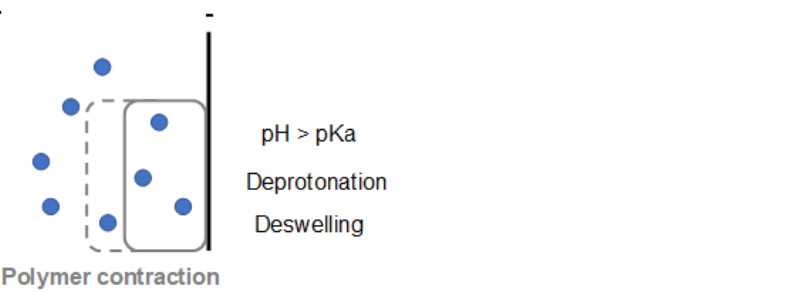
Figure 8. Electro-assisted drug delivery by forced convention mechanism for a polycationic material.